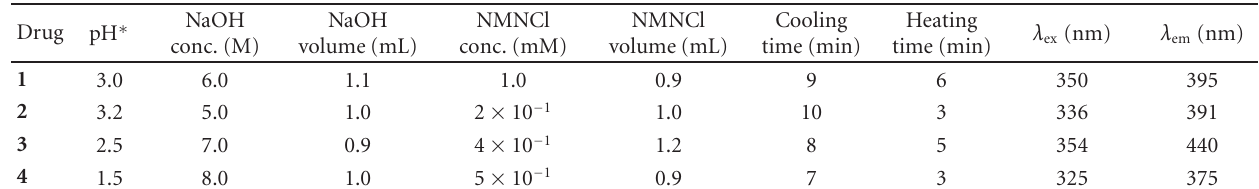
Table 1: Optimum conditions for the fluorometric procedure.